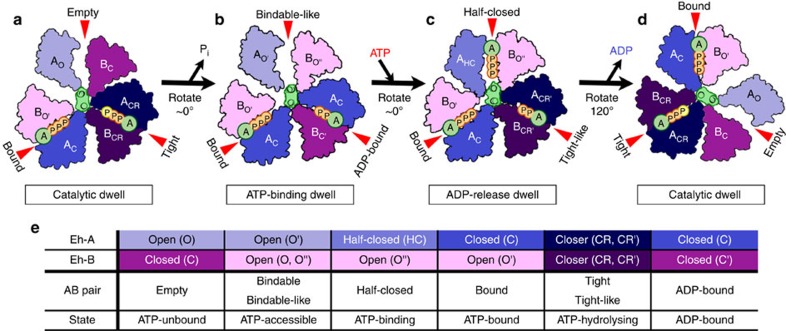
Proposed model of the rotation mechanism of Enterococcus hirae V1-ATPase.(a–d) The structure models are based on the crystal structures of 2ATPV1 (catalytic dwell; a,d), 2ADPV1 (ATP-binding dwell; b), and 3ADPV1 (ADP-release dwell; c) determined in this study. ATP indicated as a yellow ‘P' in (a) and (d) represents an ATP molecule that is committed to hydrolysis. (e) Correspondence table for all AB pairs observed in the crystal structures of the A3B3 and V1 complexes. See text for additional details.